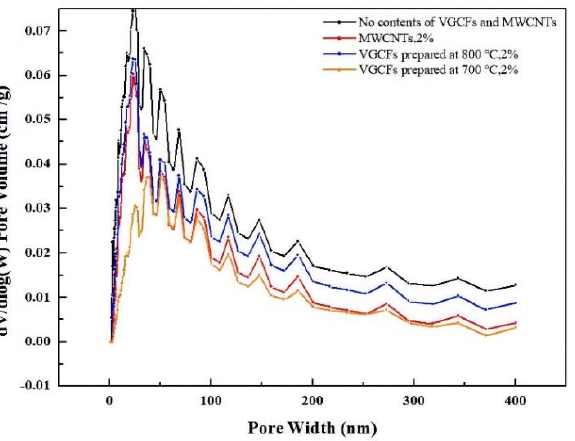
Figure 6. The effect of adding VGCFs on the pore size distribution of composite BPs.